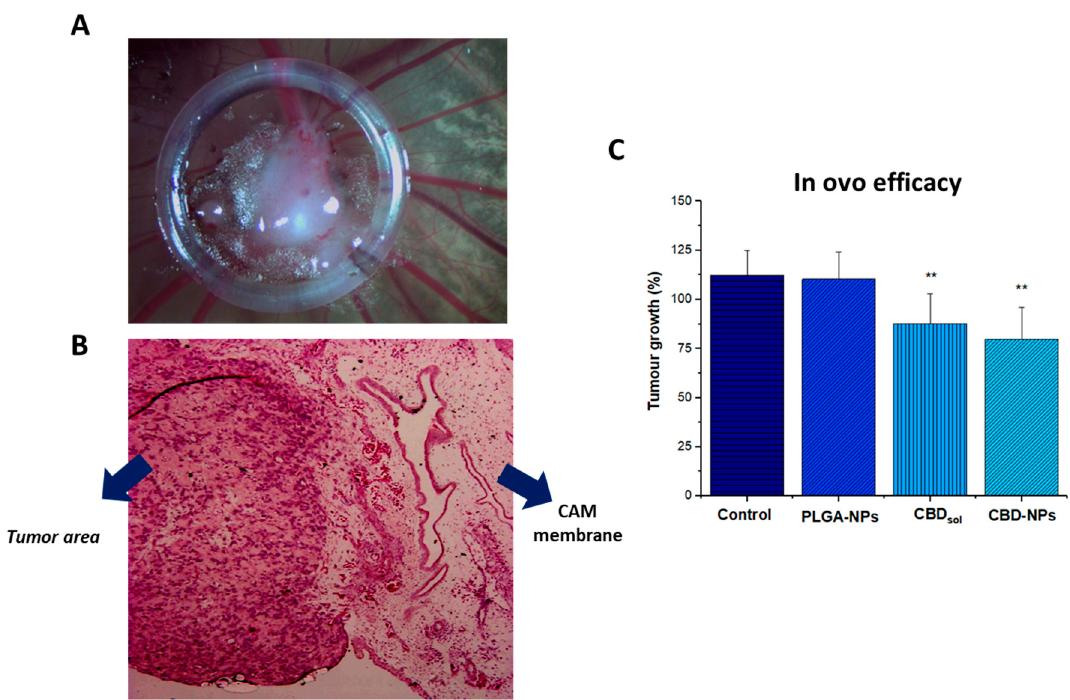
Figure 6. SKOV-3-derived tumour formed on the chorioallantoic membrane (CAM) corresponding with incubation day 11 ( A ), haematoxylin and eosin staining ( B ). Black arrows designated blood vessels. Tumour growth of SKOV-3-derived tumour after several treatments ( C ). ** Statistically significant differences ( p -value < 0.01) compared to the control (cell culture medium). At least seven eggs per condition were used ( n = 7).